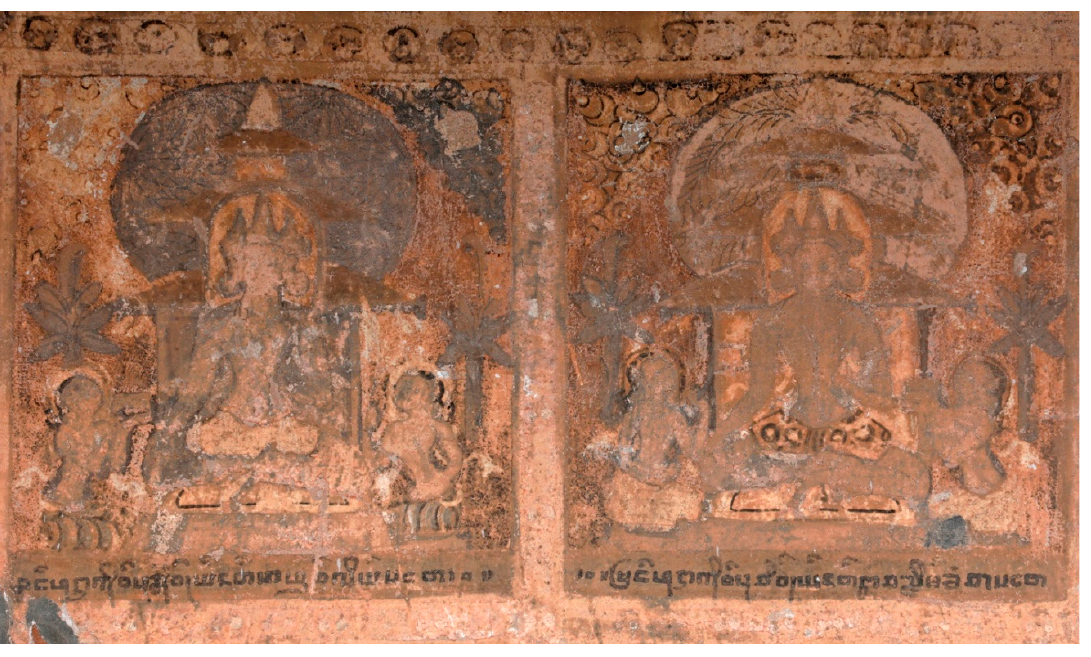
Figure 31. Pagan, Ananda, 11th century. Akataññ ū J ā taka, 90.